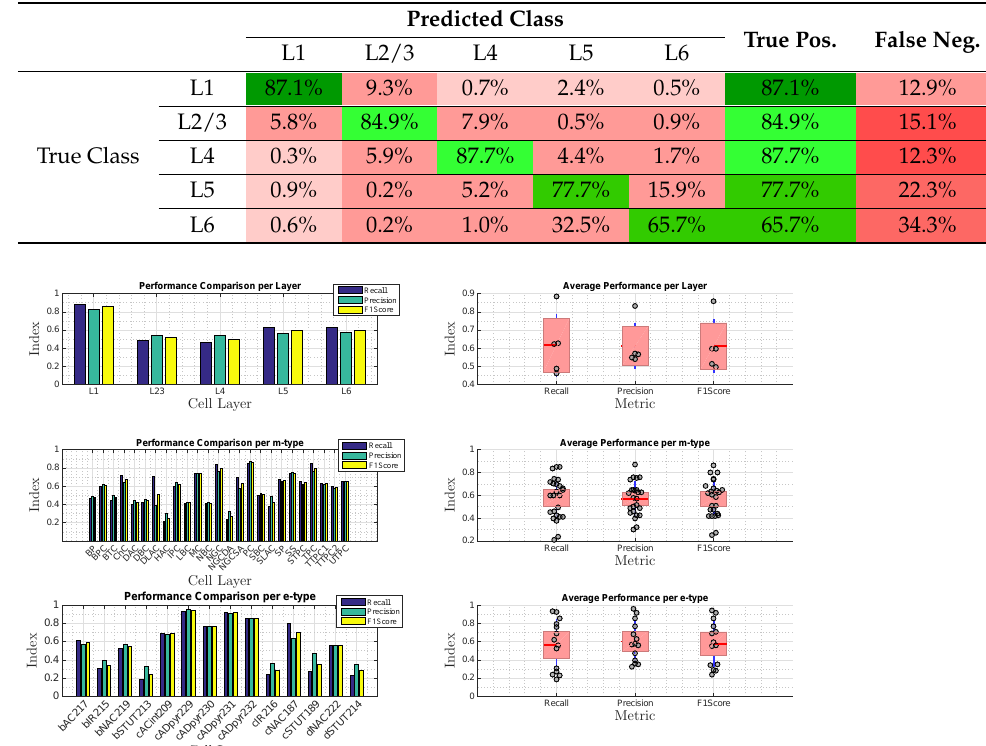
Table 4. Confusion Matrix of SVM layer − classifier. The colors represent the level of performance of the classification task per cortical layer. Green represent strong performance level, and red represent weak performance level. The darkness of the color represents its value, being the darkest the highest values. Predicted Class True Pos. False Neg. L1